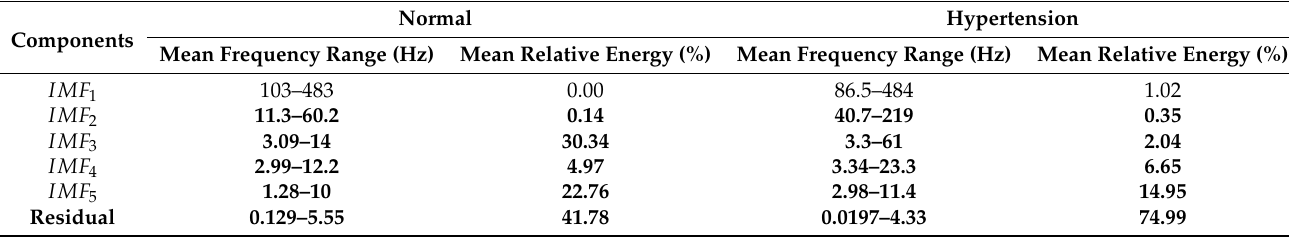
Figure 7. EMD algorithm (flow chart). Table 5. Comparison of mean relative energies and frequency ranges of various intrinsic mode functions (EMD) for Normal and Hypertension classes. Bold font indicates the selected